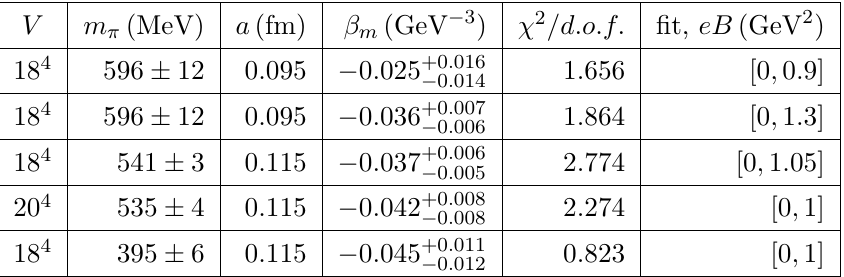
Table 3. The magnetic dipole polarizabilty (cid:12) m of the charged (cid:26) meson for the lattice spacings 0 : 095 fm, 0 : 115 fm, for the lattice volume 18 4 , various pion masses and for the lattice spacing 0 : 115 fm, the lattice volume and the pion mass 535(4) MeV with the corresponding errors and (cid:31) 2 =d:o:f . The (cid:12)t interval is shown in the last column. The results were obtained from the 2- parametric (cid:12)t according to formula